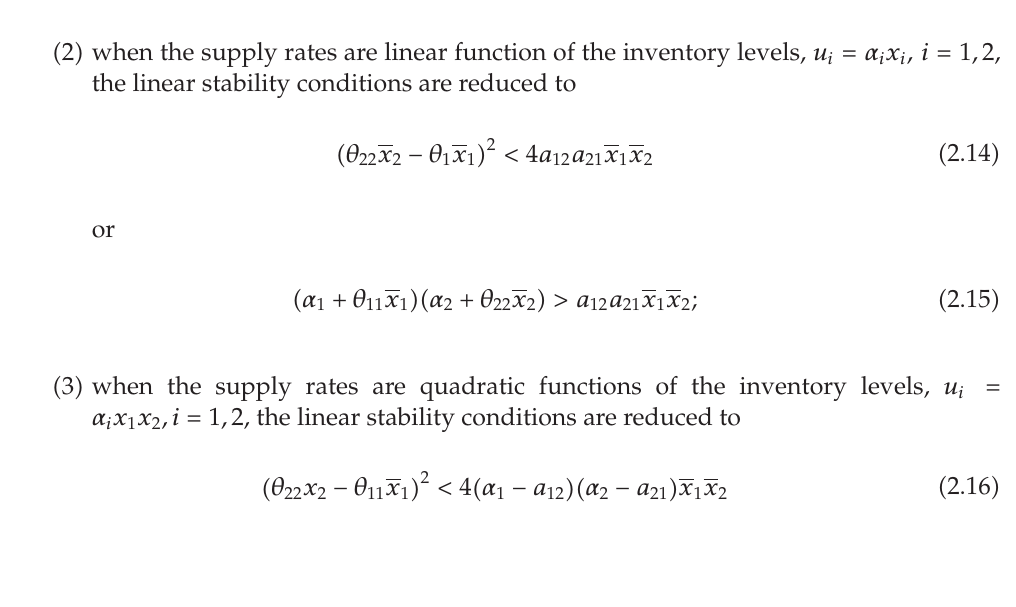
(cid:8) α x , i (cid:8) 1 , 2, i i i